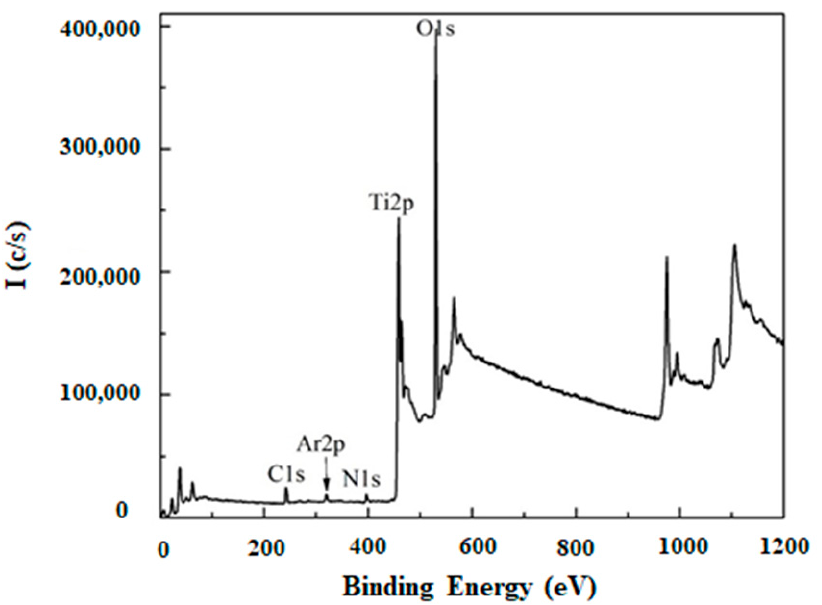
Figure 4. A wide-scan XPS spectrum of as-grown TiN film. Shown in Figure 5a is N1s spectrum of as-grown TiN film. Peak fitting of the N1s spectrum reveals that the spectrum can be deconvoluted into two peaks, one is due to Ti-N bond and the other relatively small peak can be attributed to titanium oxynitride Ti-O-N. High-resolution XPS spectra of N1s of all the samples are shown in Figure 5b. N1s peaks corresponding to Ti-N for as-grown and samples annealed at 300 and 500 ◦ C are centered at 396.8 eV, 396.6 eV, and 397.4 eV, respectively [20,30,32]. The signal of N1s in the XPS spectrum of the sample annealed at 700 ◦ C is too weak to determine the peak position indicating there is relatively less nitrogen in the sample. This could be due to breaking of Ti-N bond at high annealing temperature and exodus of nitrogen from the film. This is consistent with the XRD data where the intensity of TiN (200) peak is much smaller compared to the TiN(200) peak intensity in the other samples. The second peak of nitrogen in the N1s spectra for the as-grown and for the samples annealed at 300 ◦ C, is centered on 398.5 and 398.6 eV, which correspond to Ti-O-N formation [30,32]. Shown in Figure 5c is N1s spectra taken at different depths in the film by Ar ion etching. N1s spectra at different depths show an increase in the intensity of the peak after each etching cycle indicating more nitrogen is present in the bulk compared to the surface layers of the film. This could be due to chemisorption of oxygen from the environment resulting in oxygen occupying nitrogen position in the surface